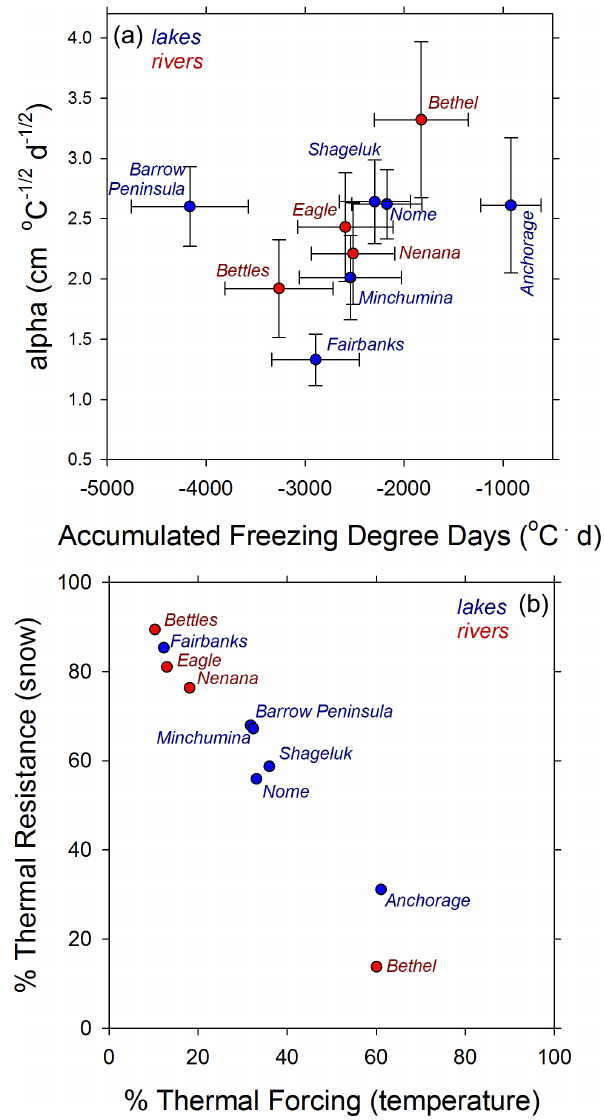
Figure 10. Comparison of mean ( ± 1SD) alpha and accumulated freezing degree day parameters for MIT records in lakes (blue) and rivers (red) (a) and the proportion of variation explained by thermal resistance and thermal forcing (b)